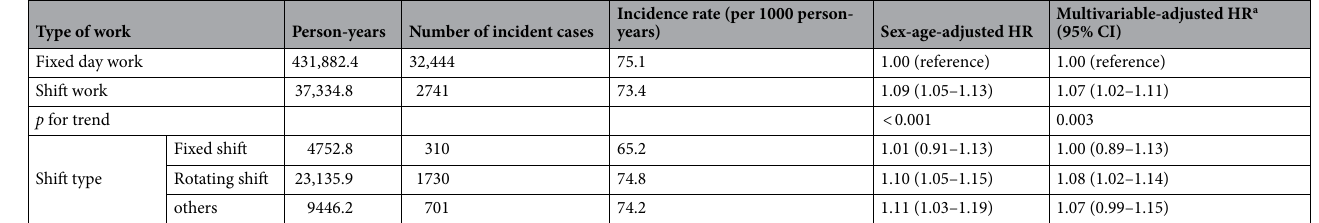
Table 2. Development of reflux esophagitis (RE) by type of work and shift type in participants. CI confidence interval, HR hazard ratio. a Adjusted for sex, age, smoking status, alcohol intake, regular exercise, education level, BMI, Diabetes, dyslipidemia and working